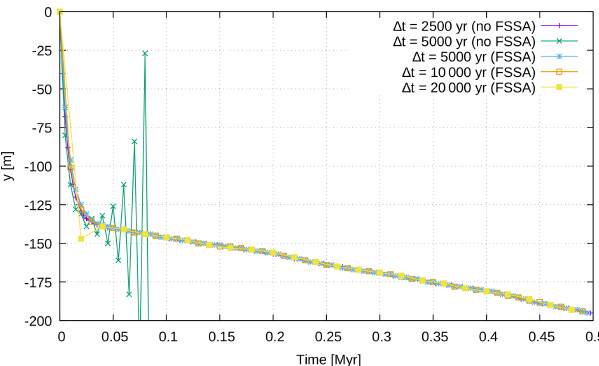
Figure E3. Altitude of the most top-left point of the grid over time, for the sloshing free surface benchmark, for different time steps with and without the